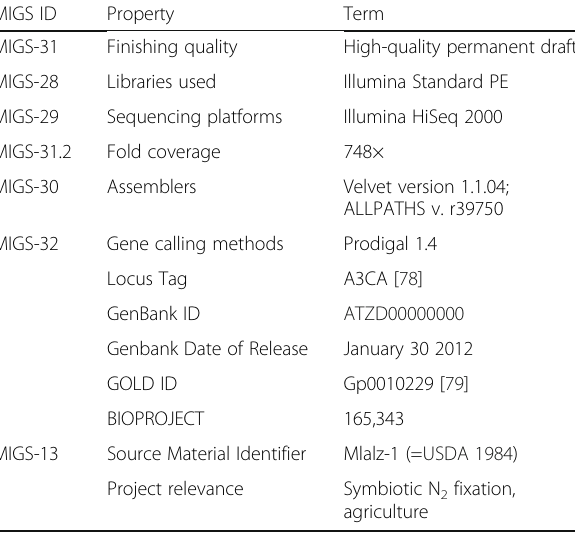
Table 2 Genome sequencing project information for Ensifer meliloti